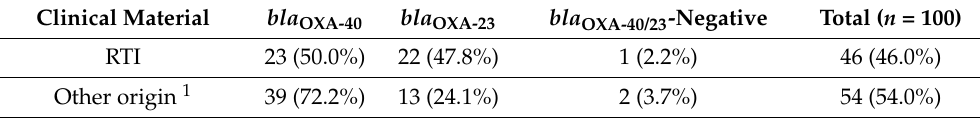
Table 4. The occurrence of bla OXA genes in A. baumannii with respect to strains’ origin.